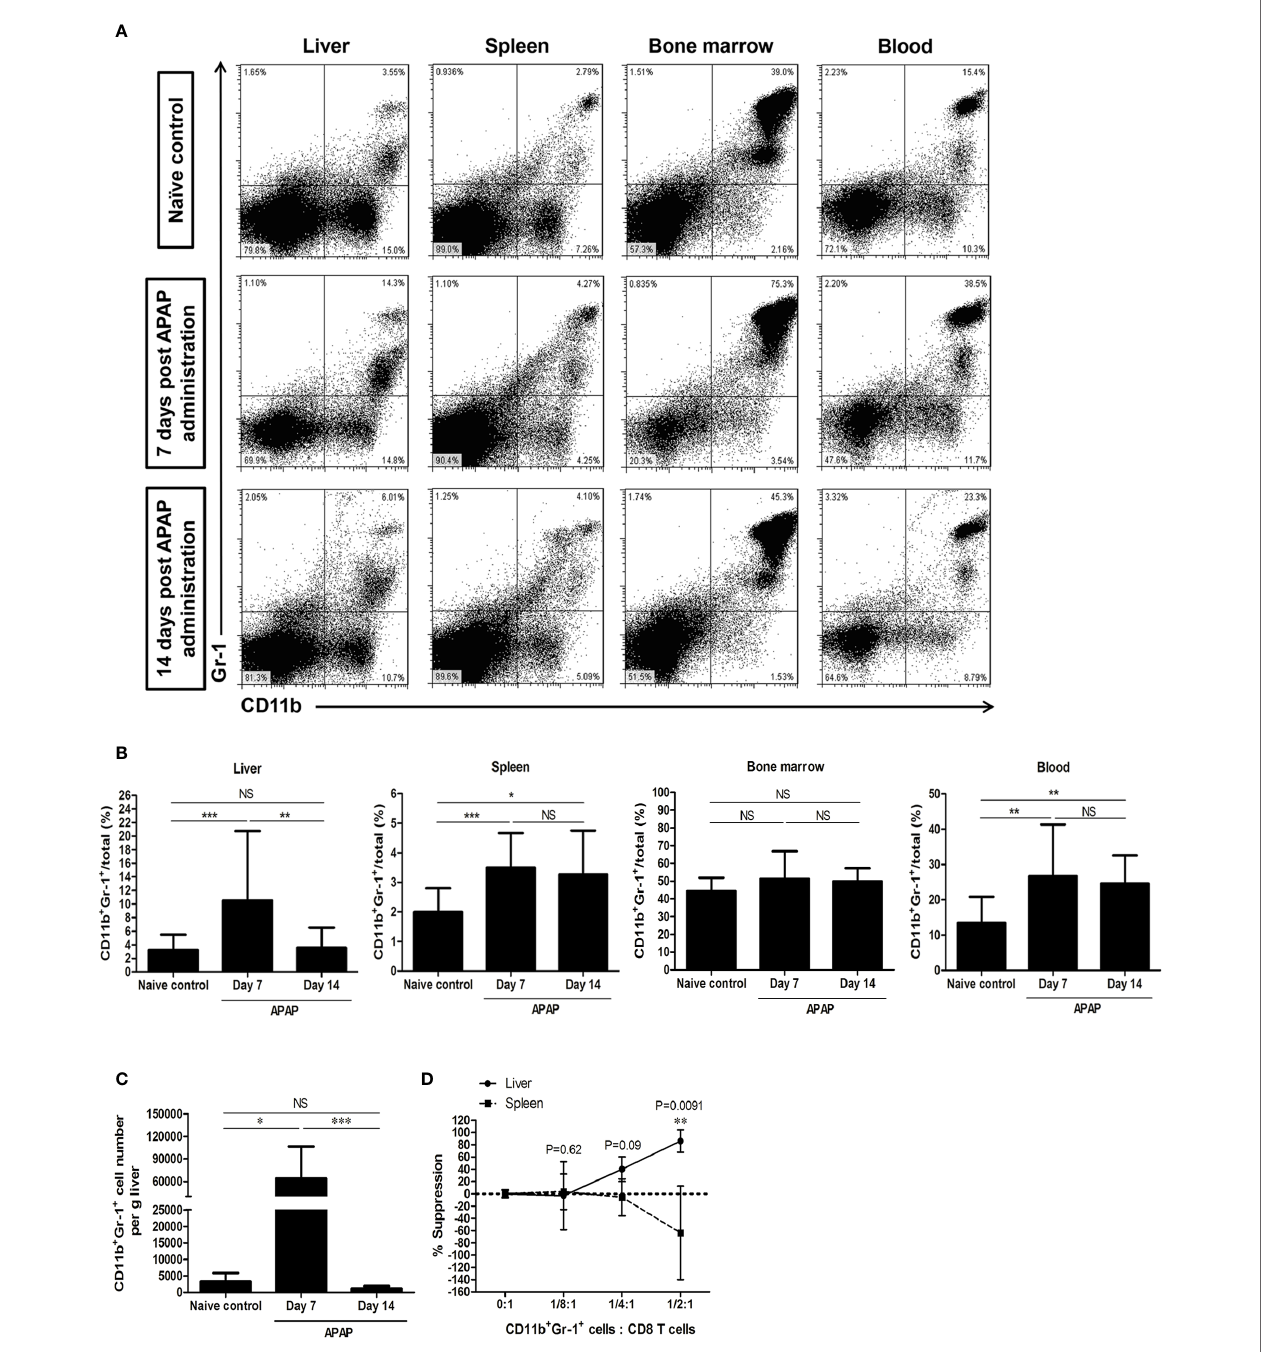
FIGURE 1 | CD11b + Gr-1 + myeloid-derived suppressor cells (MDSCs) increase in the liver after sublethal acetaminophen (APAP) challenge. (A) Representative staining of CD11b + Gr-1 + cells. (B) The frequencies of CD11b + Gr-1 + cells in different compartments enumerated at 7 days or 14 days after APAP treatment. Naïve control group was healthy mice without any treatment (n=10-18 per group). *P < 0.05, **P < 0.01, ***P < 0.001. Kruskal-Wallis test. (C) Absolute cell numbers of CD11b + Gr-1 + cells in the liver. *P < 0.05, ***P < 0.001, NS, no signi fi cance, Kruskal-Wallis test. (D) The suppressive abilities of CD11b + Gr-1 + cells sorted either from the liver or the spleen at 7 days after APAP pretreatment, Mann-Whitney test. Data were expressed as mean ±